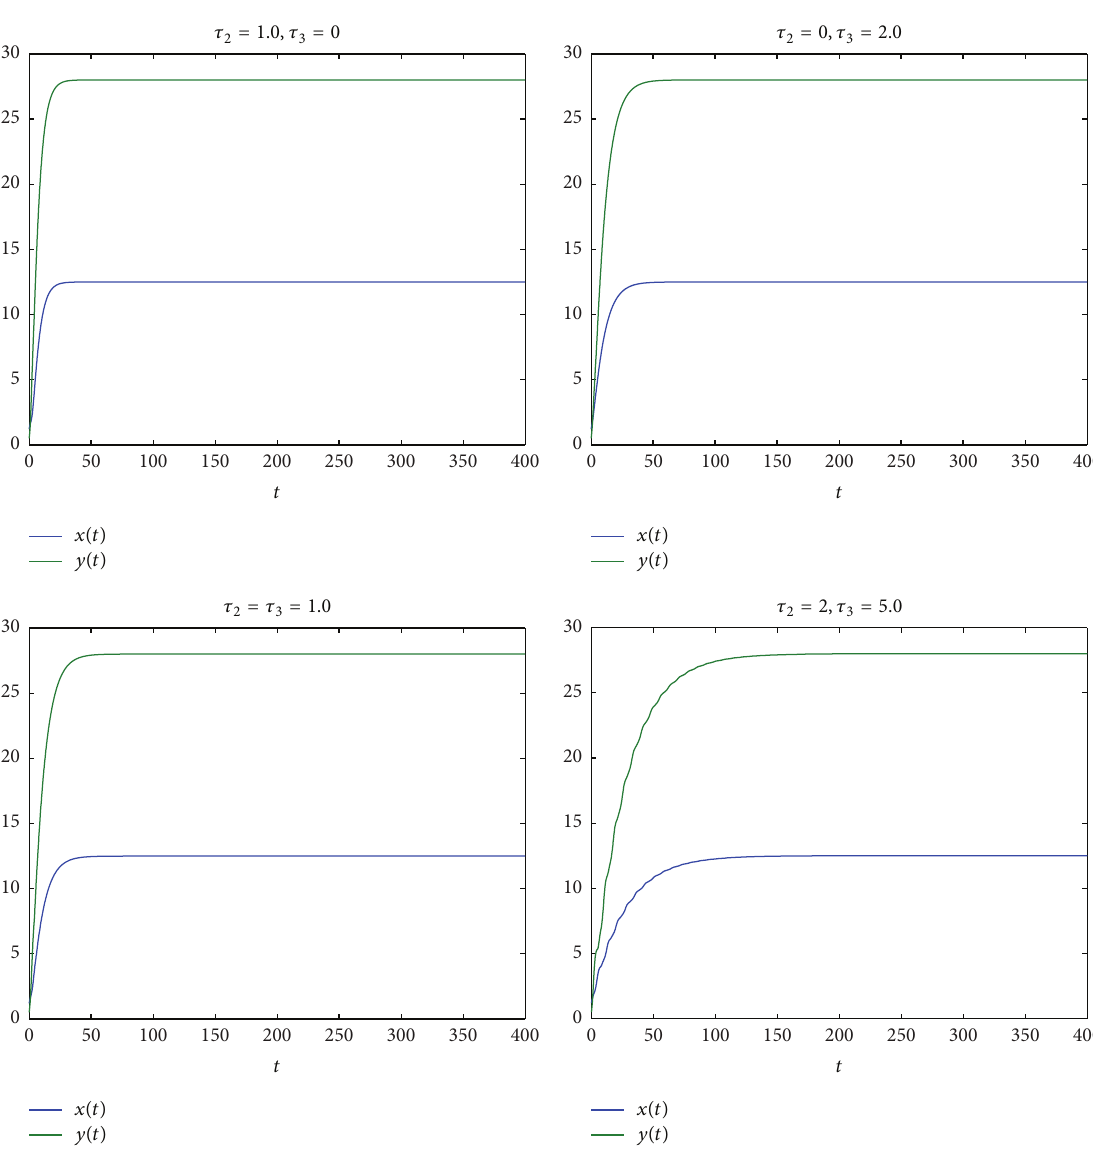
Figure 2: MATLAB simulation shows that the positive equilibrium of system (115) is always locally asymptotically stable with any values of 𝜏 𝜏 2 and 3 with initial value “1.2,